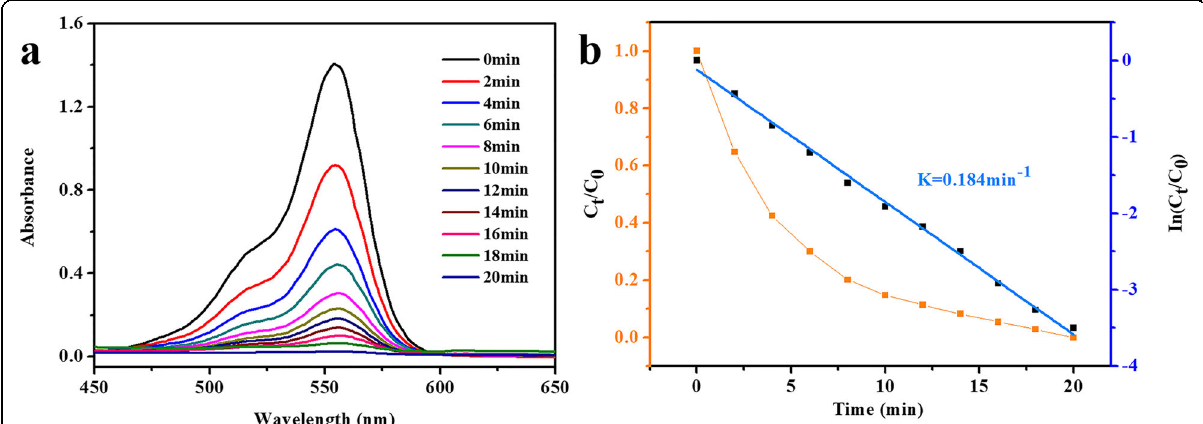
Fig. 11 Catalytic performance of GA@AgNPs-LA-CP for the catalysis of RhB. Time-dependent UV-vis spectral changes a and the reaction kinetics curve